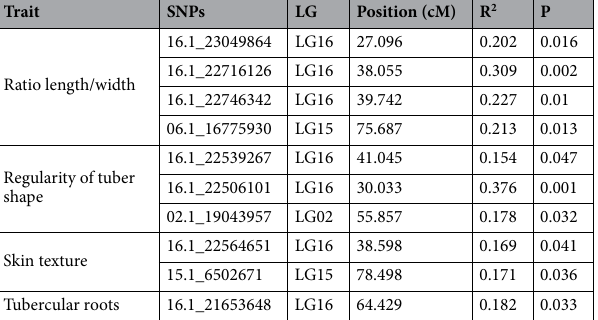
Table 6. Summary of QTLs validated on the diversity panel. LG linkage group, R 2 Pearson determination coefficients, p level of significance (p <